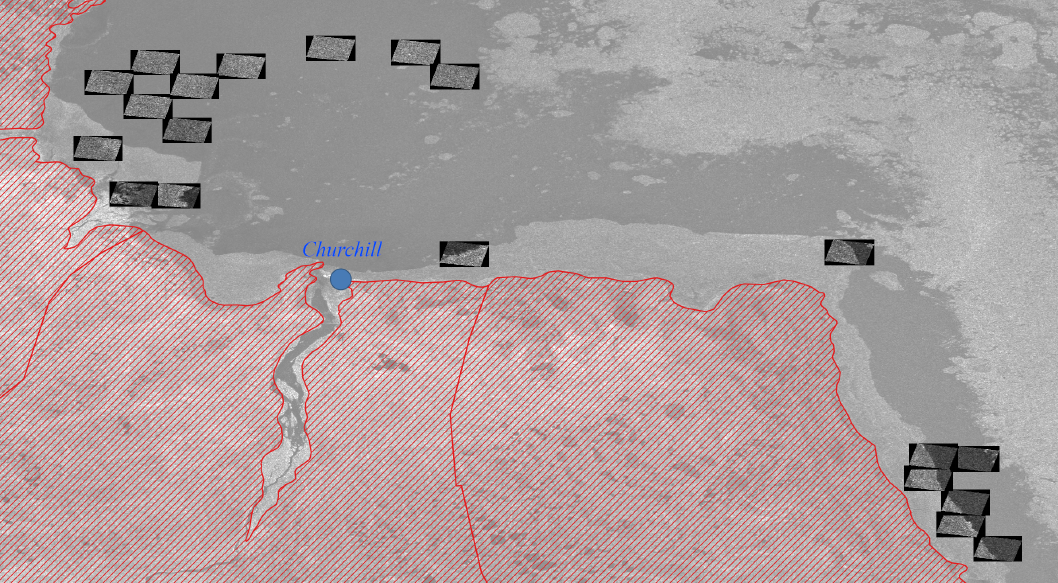
Figure 2. Candidate dataset samples consist of SAR image sub-regions, highlighted in the figure, centred about ice chart image analysis sample coordinates. Background SAR image showing the southwestern region of the Hudson Bay and Churchill, Manitoba, indicated by the blue dot. The red hatched area denotes